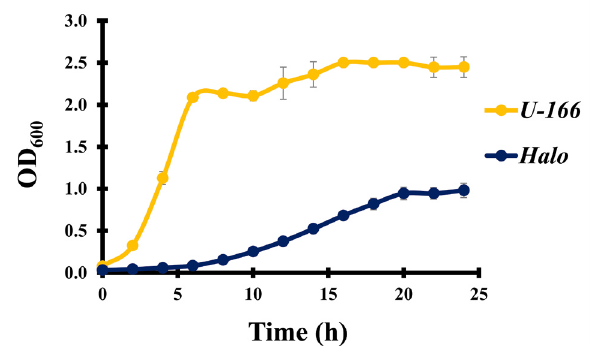
Figure 1. Growth curves from Halo and U-166 denitrifying population. The growth profiles of both DN consortia were analyzed